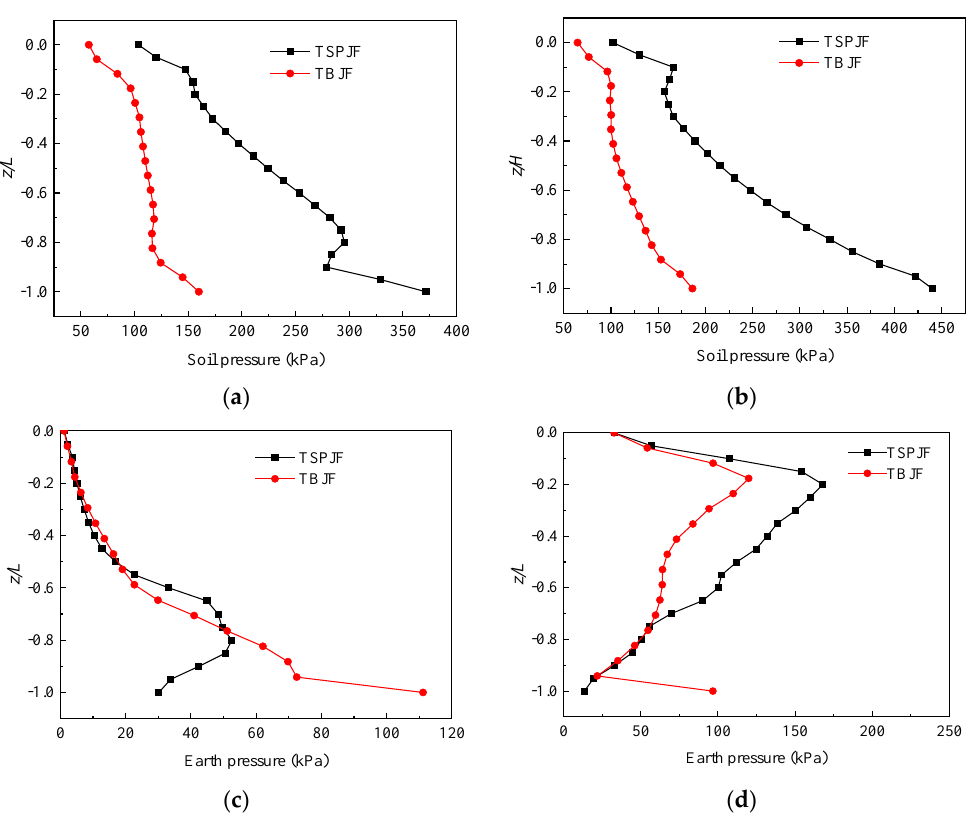
Figure 6. Comparison of earth pressure along the depth between the TSPJF and TBJF. ( a ) earth pressure on inner skirt of 1# bucket at P1; ( b ) earth pressure on inner skirt of 1# bucket at P2; ( c ) earth pressure on outer skirt of 1# bucket at P1; ( d ) earth pressure on outer skirt of 1# bucket at P2. The vertical capacity of the TSPJF and TBJF is composed of four parts: the friction along the inside bucket skirt, the friction along the outside bucket skirt, the vertical resistance on the bucket lid, and the end resistance. Figure 7 shows the resistance provided by each part of the foundations at different vertical loads. For the two foundations, the vertical load is mainly borne by the inside and outside frictional resistance when the vertical load is small. With the continuous increase of the vertical load, the inside frictional resistance and the vertical resistance from the bucket lid increase significantly, showing a